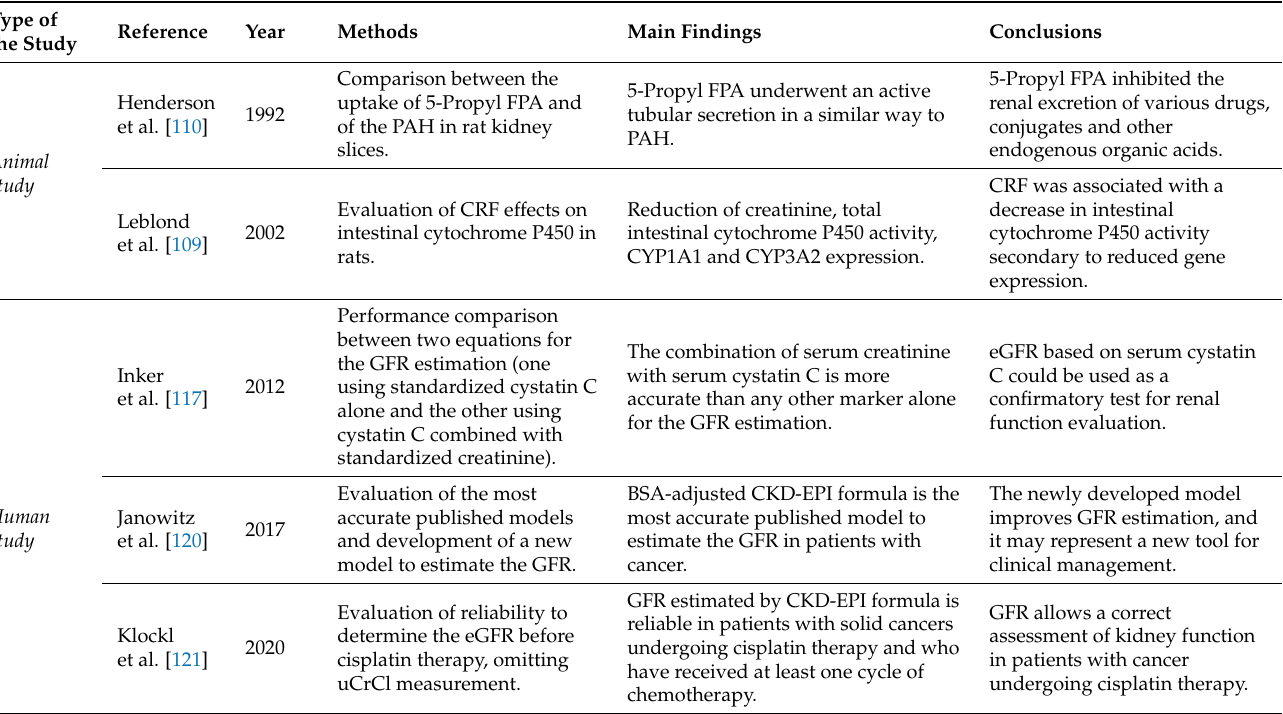
Table 4. Main studies on the administration of chemotherapeutic drugs in CKD